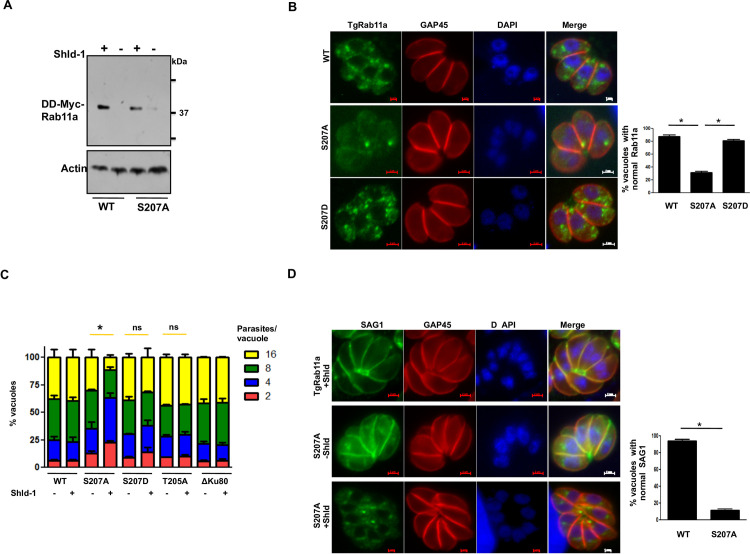
TgCDPK7-mediated phosphorylation of TgRab11a at S207 is critical for its function.A. DD-Myc-TgRab11a or its S207A mutant was ectopically expressed in T. gondii in ΔKu80 parasites. Shld-1 was added for 4h or parasites were left untreated. Western blotting was performed using anti-myc antibody and Actin was used as a loading control. B. Shld-1 was added for 4h to parasites ectopically expressing DD-Myc-TgRab11a or its S207A and S207D mutants in ΔKu80 parasites. IFA was performed using anti-myc and anti-GAP45 antibody. While WT TgRab11a and S207D exhibited punctate localization, S207A mutant was diffused in parasite cytoplasm in most cases. Right Panel, Quantification of vacuoles containing normal punctate TgRab11a or S207A/D staining, from experiments described in the left panel [Mean ±SE, *, n = 3 (WT and S207A) and n = 2 (S207D), p<0.0001, t-test]. C. DD-Myc-TgRab11a or its S207A, T205A, S207D mutants were ectopically expressed in T. gondii. Shld-1 was added for 16h and the number of parasites per vacuole was determined after additional 8h. Data represent Mean ± SE, n = 3 and at least 200 vacuoles were counted for each condition (ANOVA; WT, S207A, S207D: n = 3, T205A: n = 2. *, p<0.05, ns-not significant). D. IFA was performed on parasites expressing WT TgRab11a or its S207A mutant in the absence or presence of Shld-1 as described in panel B using antibodies against SAG1 and GAP45. Right Panel, Quantification of vacuoles containing normal SAG1 staining, which was at the parasite periphery, from experiments described in left panel. Data are mean ± SE of three independent experiments and at least 200 vacuoles were counted for each condition (*, n = 4, p<0.001, ANOVA).